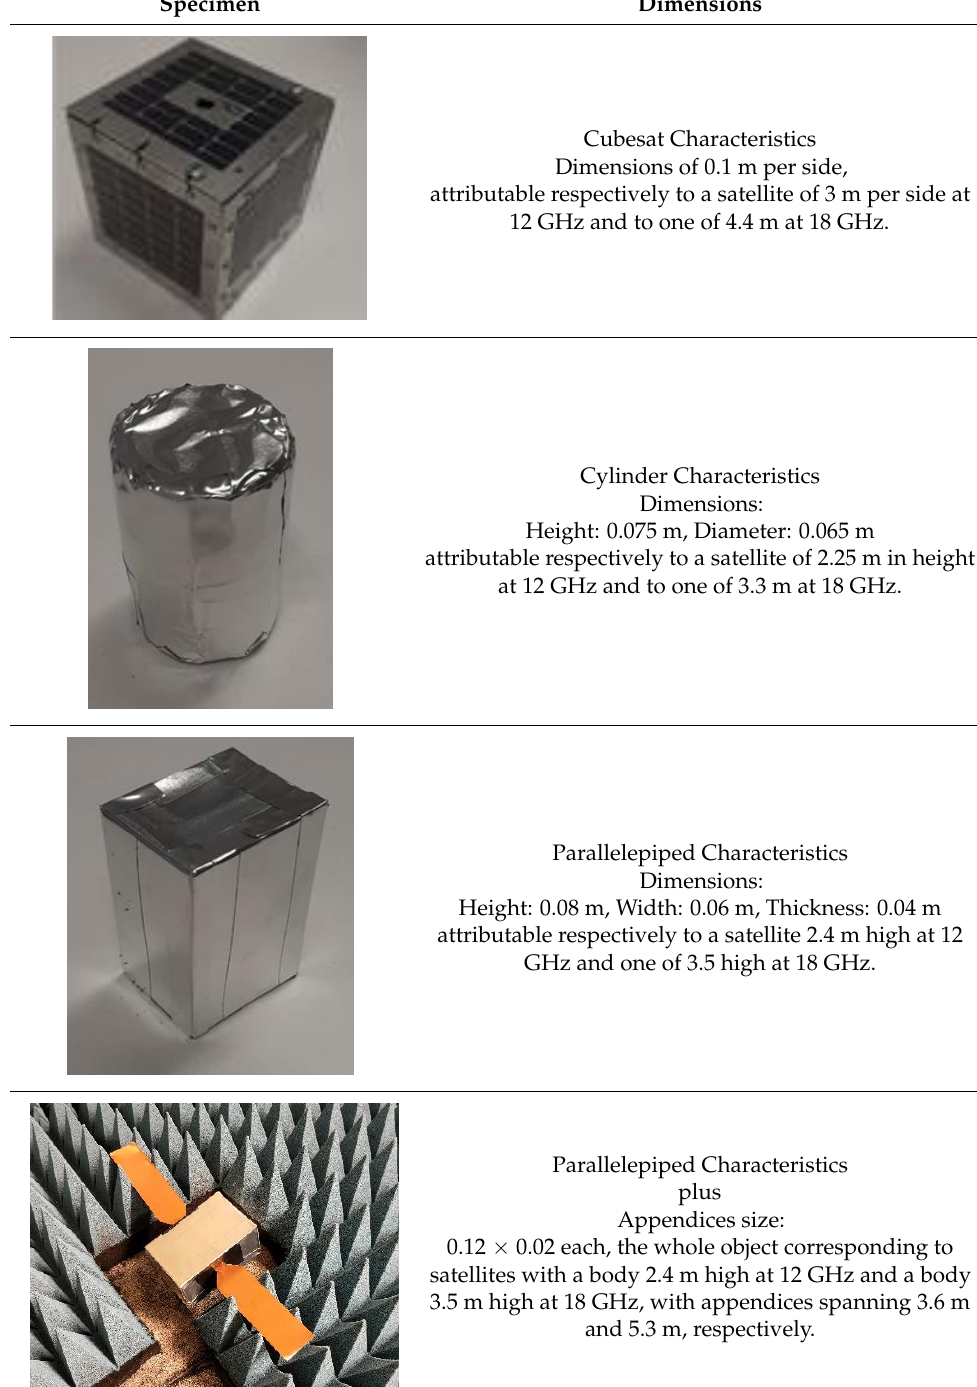
Table 1. Pictures and characteristics of the samples under investigation, having a different geometry in order to evaluate different hypothetical orbiting objects. Wavelengths of a maximum of 2.5 cm and a minimum of 1.7 cm were considered for the measurements and scaling process.